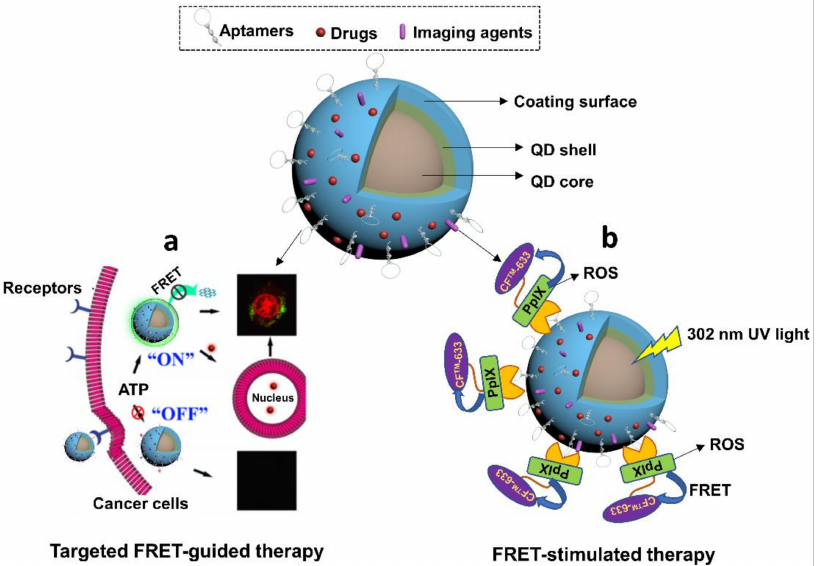
Figure 9. Schematic diagram of aptamer-empowered QDs nanomaterials. ( a ) ATP-triggered DOX re- lease and FRET-guided targeted anti-cancer therapy. It’s modified with permission of reference [164]. Copyright 2015 ACS publishing. ( b ) UV-mediated FRET imaging and ROS-driven targeted photody- namic therapy of cervical cancer. It’s modified with permission of reference [165]. Copyright 2016 RSC